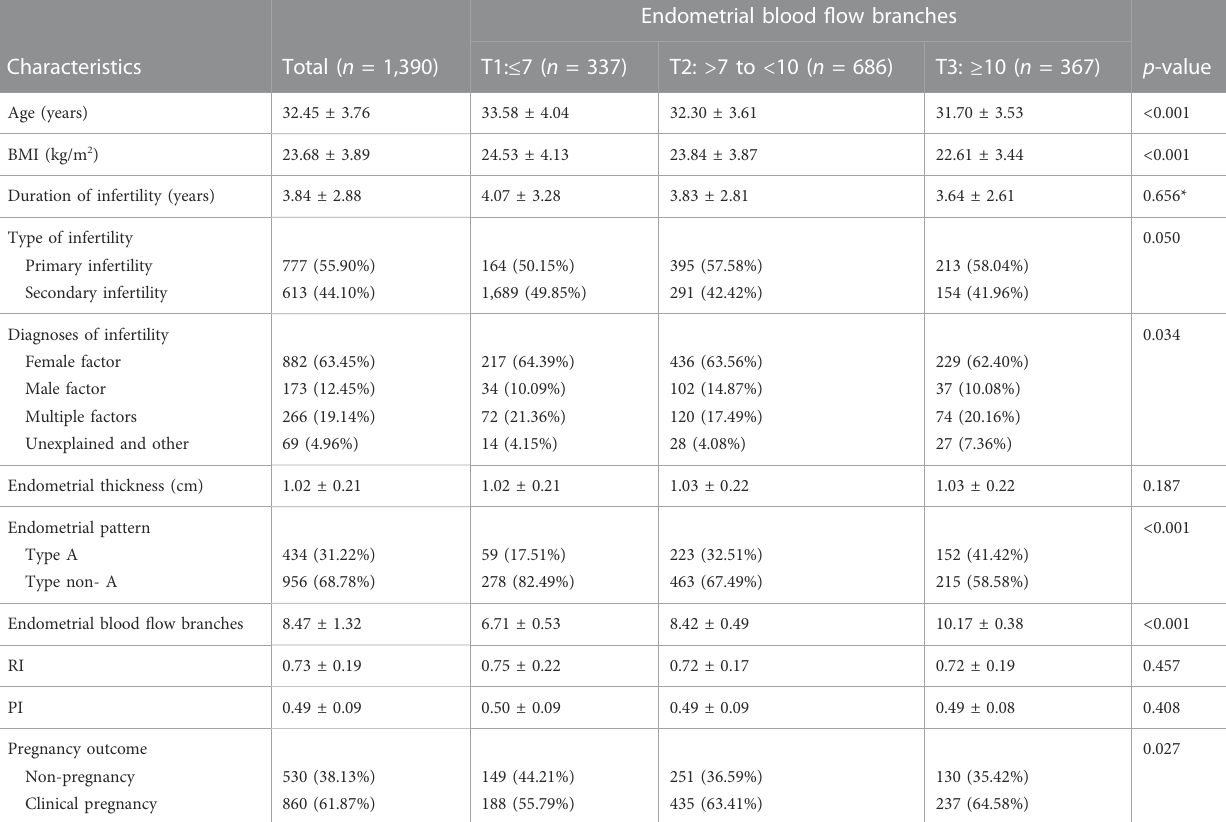
TABLE 1 Baseline characteristics of the study population by tertiles of the endometrial blood fl ow